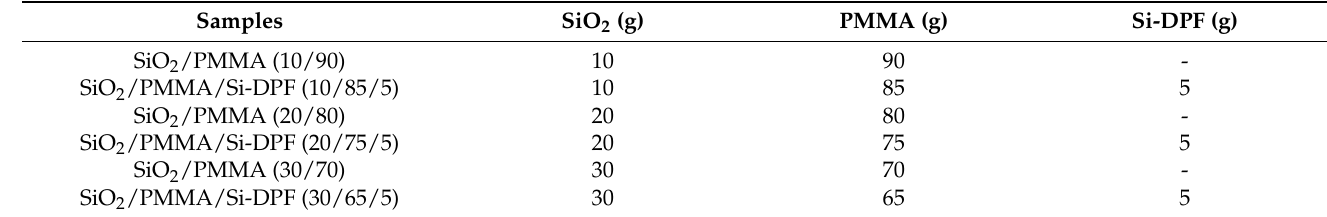
Table 2. Formulation of various SiO 2 /PMMA